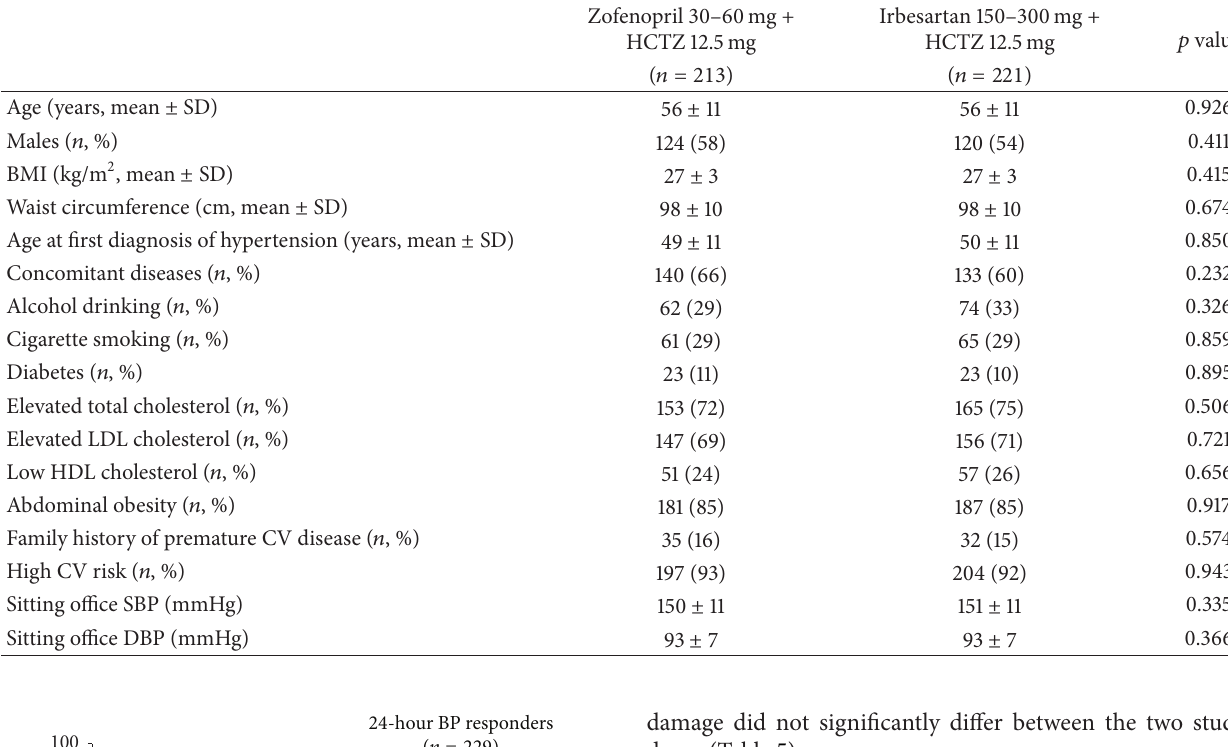
Table 1: Demographic and clinical data of the patients of the intention-to-treat population at the time of randomization ( 𝑛 = 434 ). Data are separately shown for the two groups of randomization and reported as mean ( ± SD) or absolute ( 𝑛 ) and relative frequency (%). BMI: Body Mass Index; LDL: Low Density Lipoprotein; HDL: High Density Lipoprotein; CV: cardiovascular; SBP: systolic blood pressure; DBP: diastolic blood pressure.